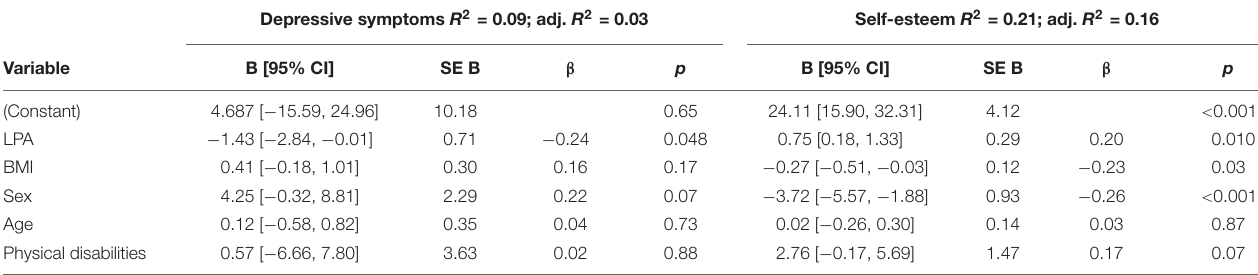
TABLE 4 | Regression analyses of LPA on depressive symptoms and self-esteem.